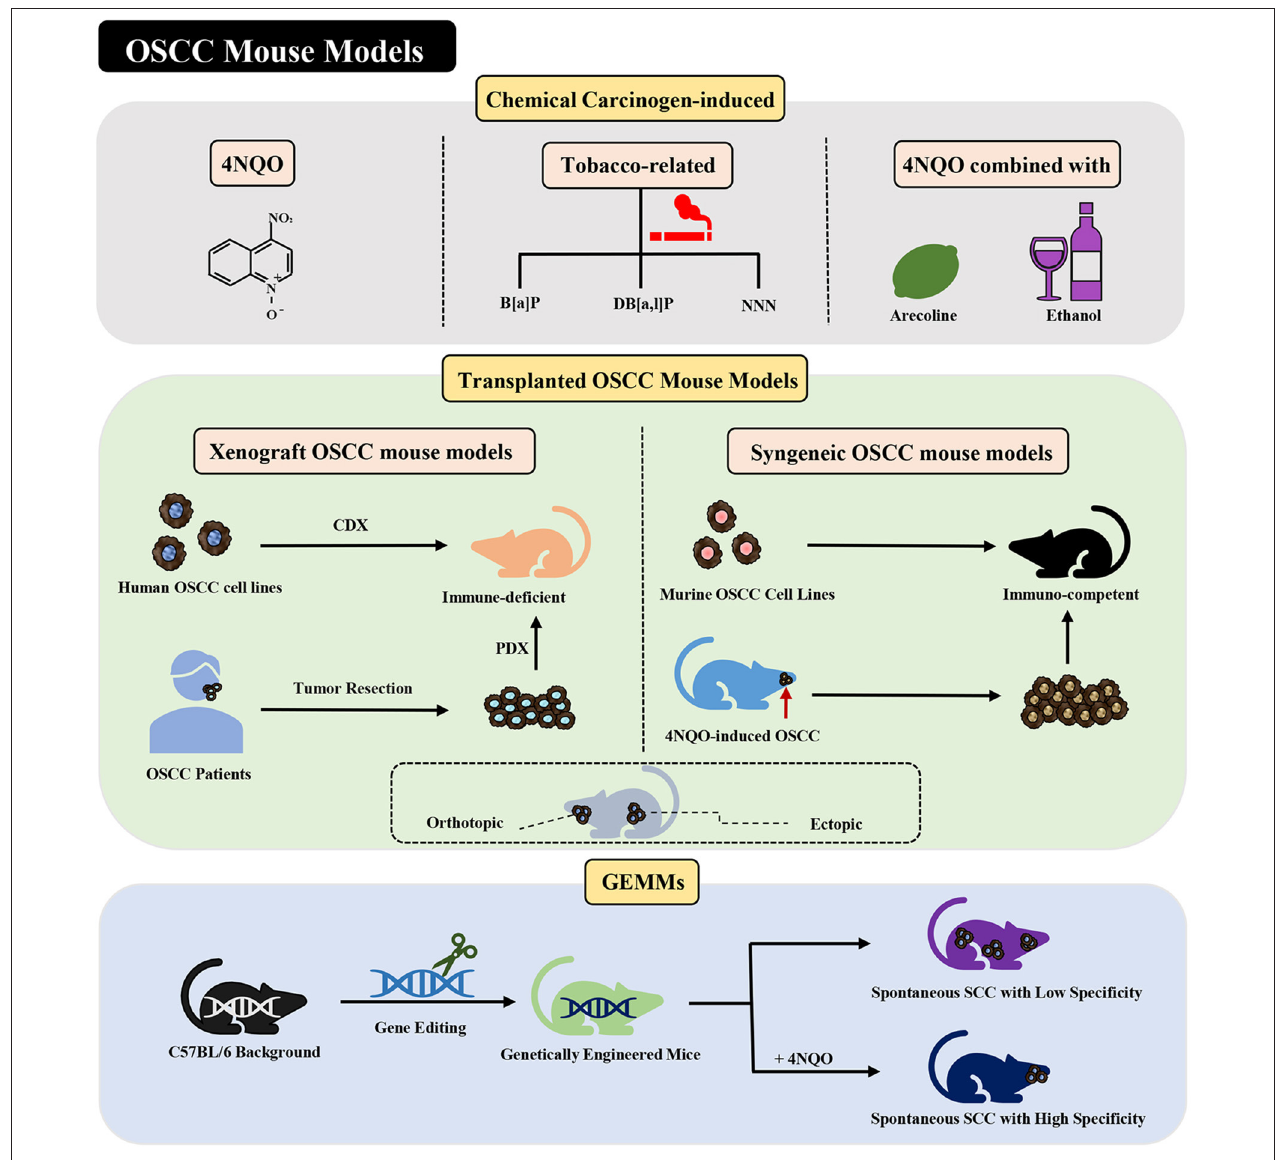
FIGURE 1 | Current mouse models of OSCC. Various methods of establishing OSCC mouse models can be divided into three categories: chemical carcinogen-induced, transplanted, and genetically engineered mouse models. Adhesions: OSCC, oral squamous cell carcinoma; 4NQO,